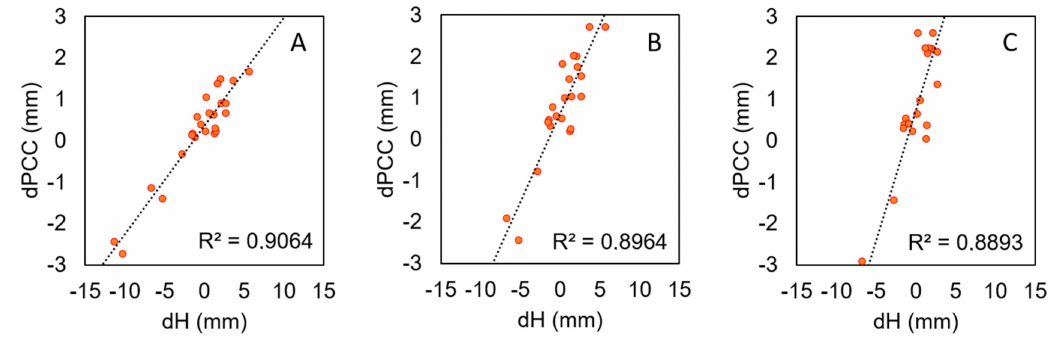
Figure 6. Correlation between mean value of dPCCs for selected sections and estimated height differences (dH). Three sections of dPCC are shown: ( A ) from 0 to 90; ( B ) from 0 to 50; ( C ) from 0 to 15.